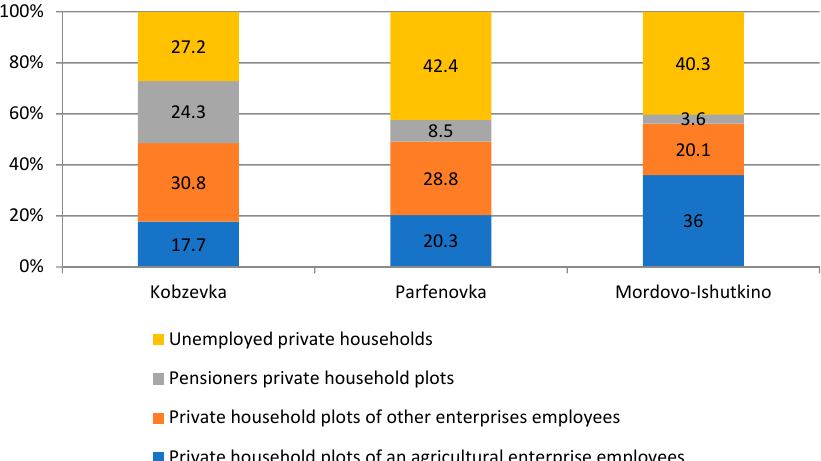
Figure 5. Comparison of private household plots by owners’ employment in 2014–2018.